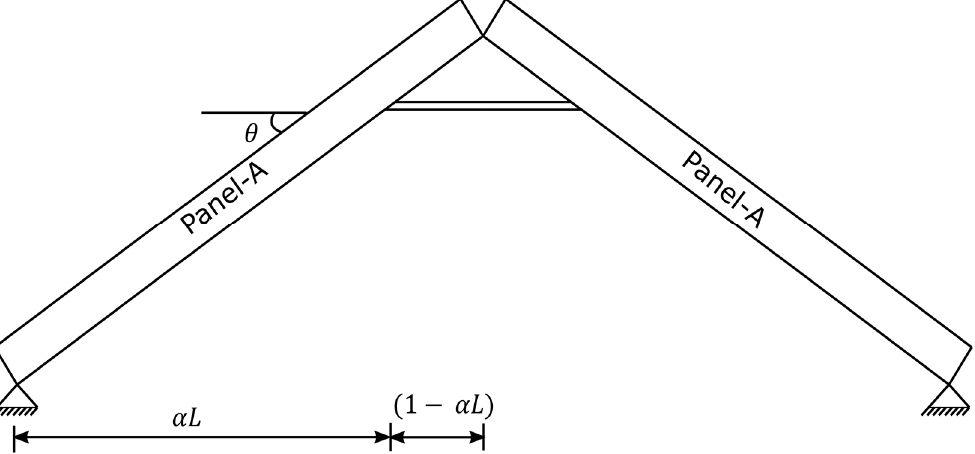
Figure 15. The apex connection idealized as rafter support system eave support with Collar Strut.